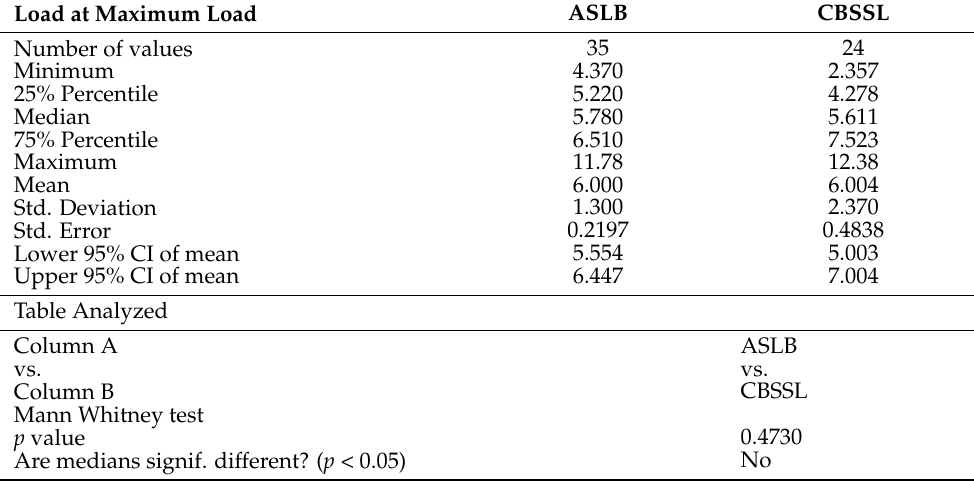
Table A4. Load at maximum load: active vs. conventional stainless steel ligature brackets. Load at Maximum Load